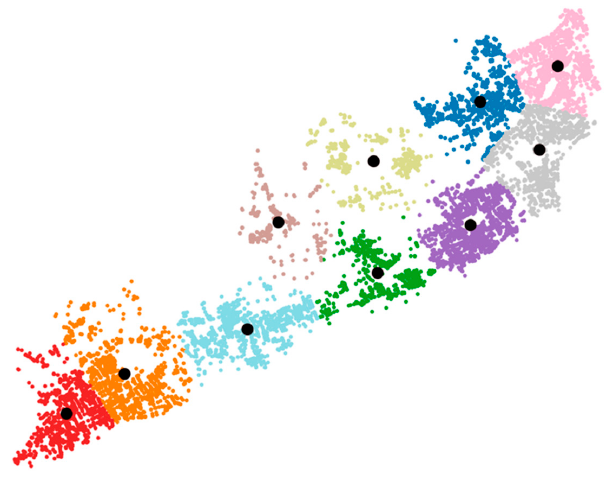
Figure 1. Facility location.